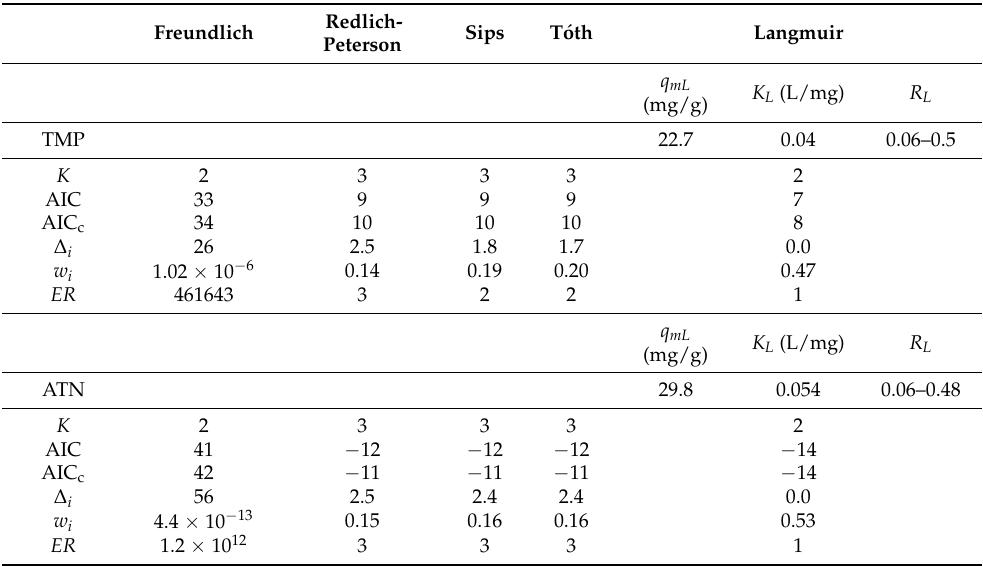
Table 2. Results of model selection among five isotherm models based on AIC for adsorption equilibrium modeling and Langmuir parameters derived for TMP or ATN adsorption onto PPH.